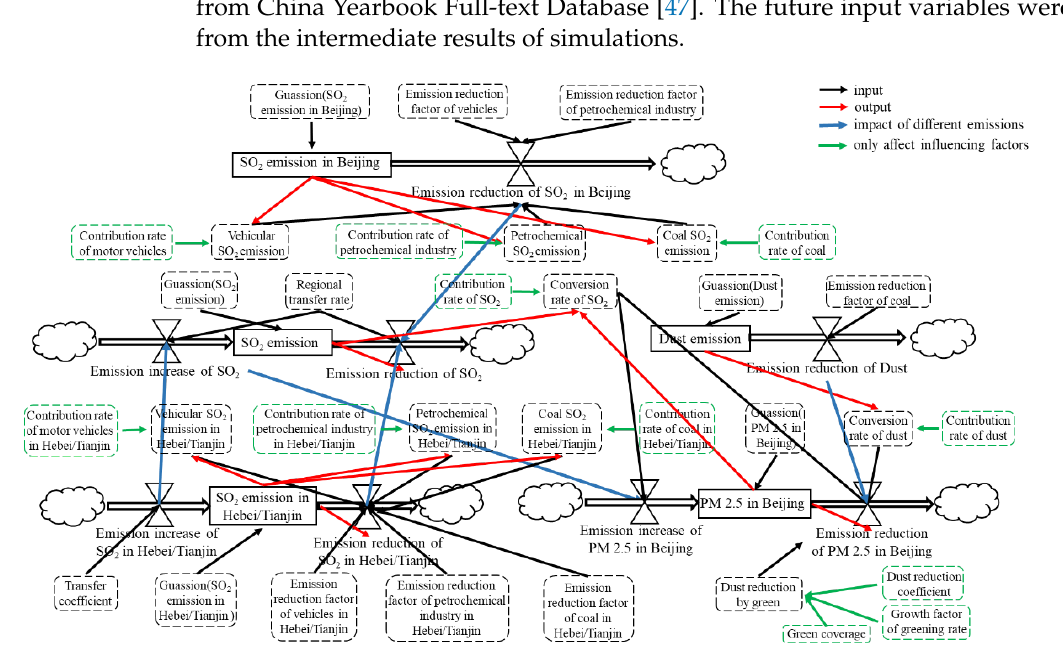
Figure 11. Overall dynamical model flow chart of Beijing urban haze system.